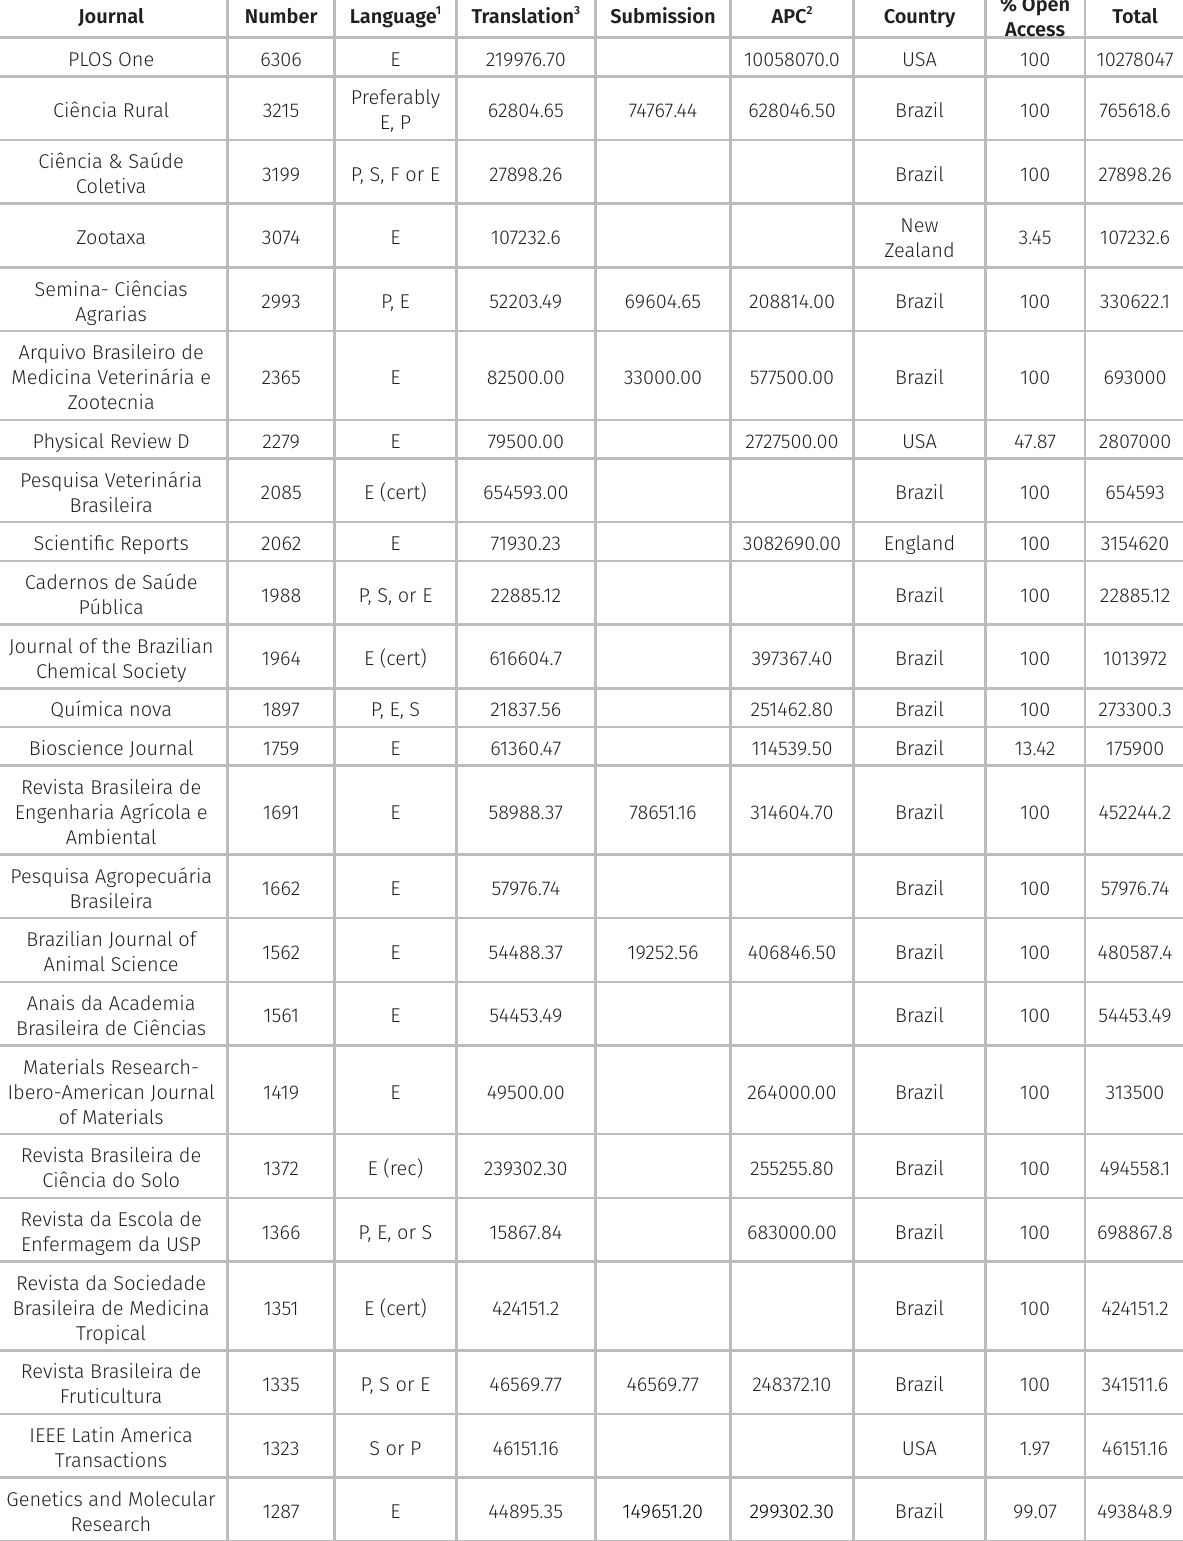
Table II. Publishing costs (USD) for the top 50 Journals where Brazilian authors publish (1USD =